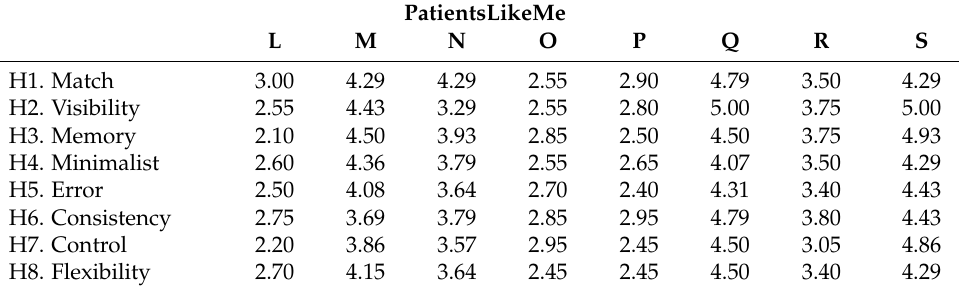
Table 7. Average usability assessments in PatientsLikeMe (1 of